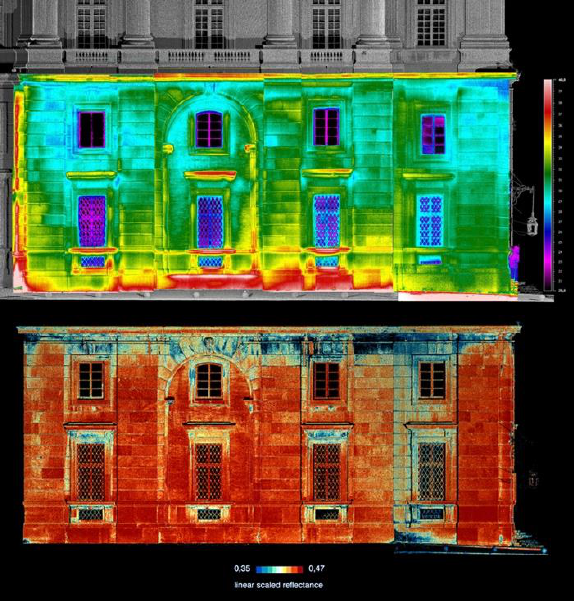
Figure 16. Comparison between colored point cloud with thermographic data and reflection